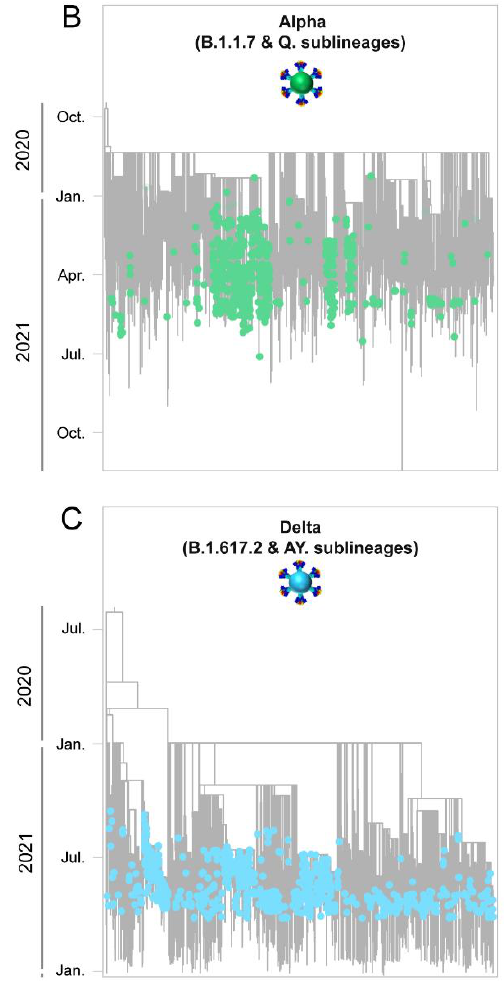
Figure 6. Time-scaled migration history for the datasets used for reconstructing the history of the spread of ( A ) B.1.258 & sublineages (red circles), ( B ) Alpha (B.1.1.7 & Q. sublineages, green circles), and ( C ) Delta (B.1.617.2 & AY. sublineages, blue circles). Red and green semitransparent circles represent the Cypriot B.1.258 & sublineages and Alpha (B.1.1.7 & Q. sublineages) genomes, respectively, collected during the April 2020 to January 2021 period [29]. Gray tips represent reference sequences downloaded from GISAID (accessed on 30 March 2022) [41].